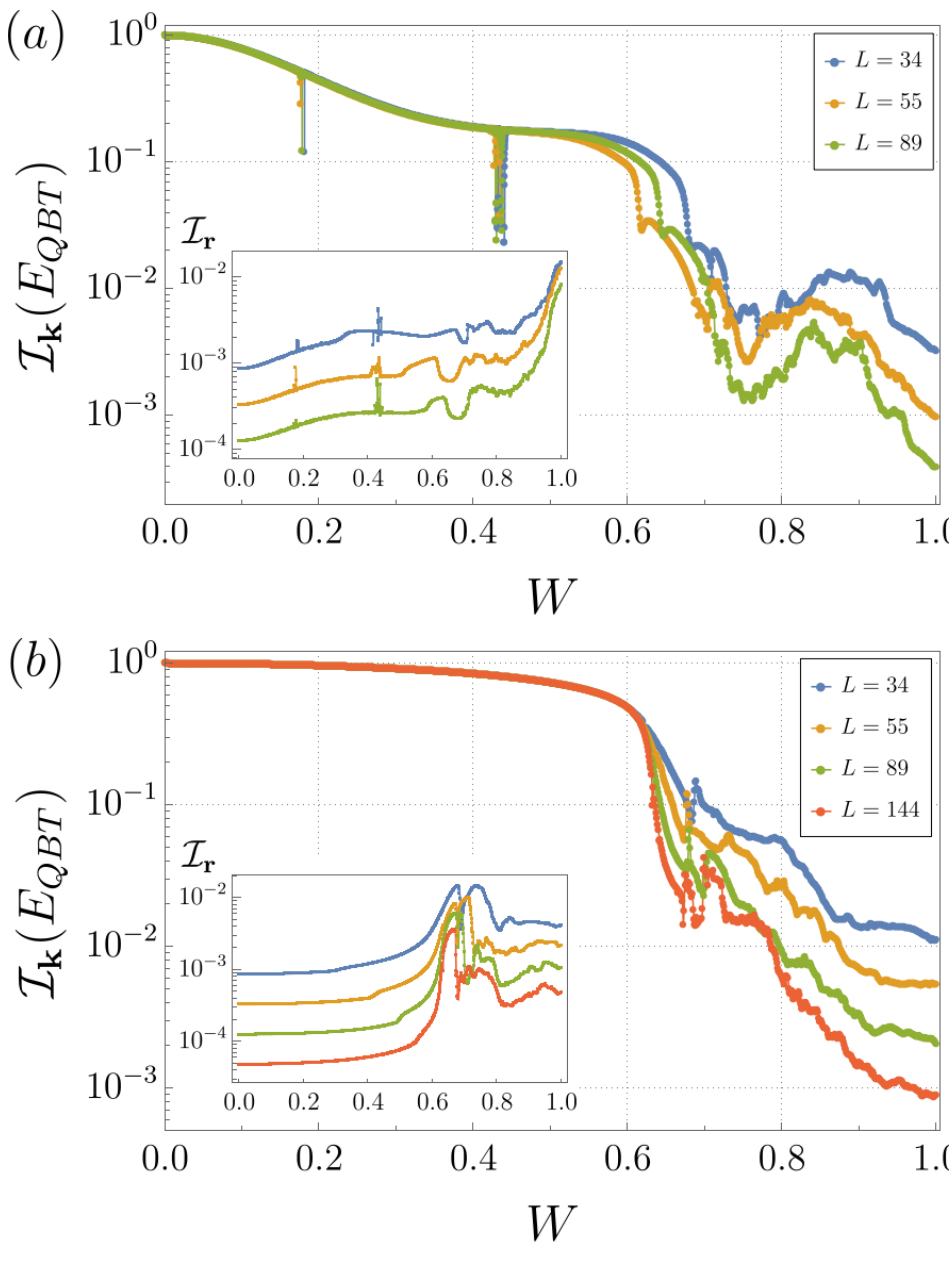
Figure 7: Momentum space delocalization : The scaling of IPR in momentum space (and real space shown in the insets) with the system size L for wave vectors (a) / 2 π = F / L , (b) Q / 2 π = F / L . Sharp suppression of IPR is observed in Q L n − 4 L n − 2 (a), which coincides with the band flattening and magic-angle condition. Apart from these small regions, the IPR is independent of the system size prior to the main tran- sition, indicating the QBT state is localized in the momentum basis. In contrast, the IPR decrease as the L becomes larger, and the QBT state is delocalized in momentum space for large W . The insets are the real space IPR for the same parameters. The fact that the real space IPR does not reach the L -independent state infers that the system does not reach true localized phase in real